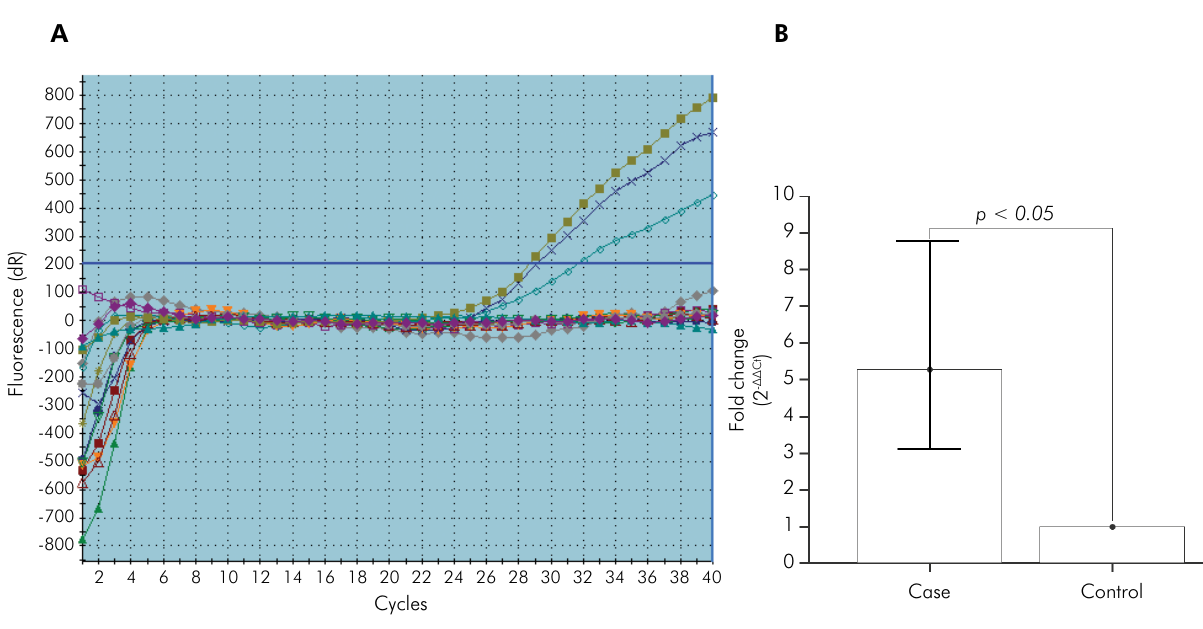
Figure 3. (A) miR-141 expression detected/undetected in representative NPC biopsy samples. (B) qRT-PCR showing up-regulation of miR-141 in NPC biopsy samples compared with non-cancerous samples.